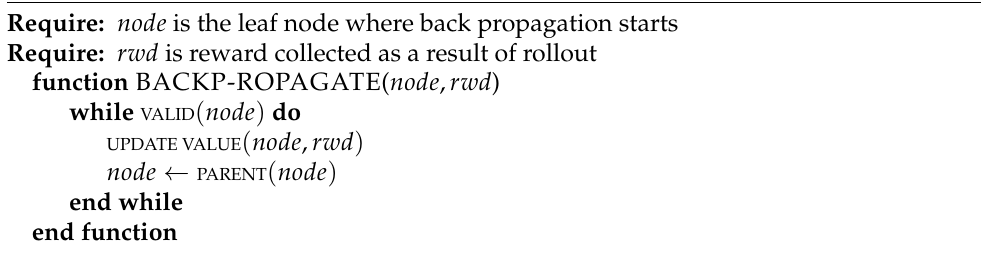
Algorithm 3 BACK-PROPAGATE algorithm that updates the value of the nodes traversed during the